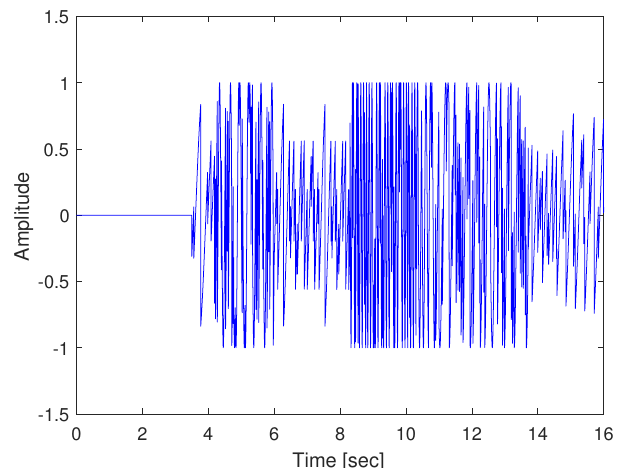
Figure 3. Laser interferometric intensity signal ( I y ) for spectrum analysis.